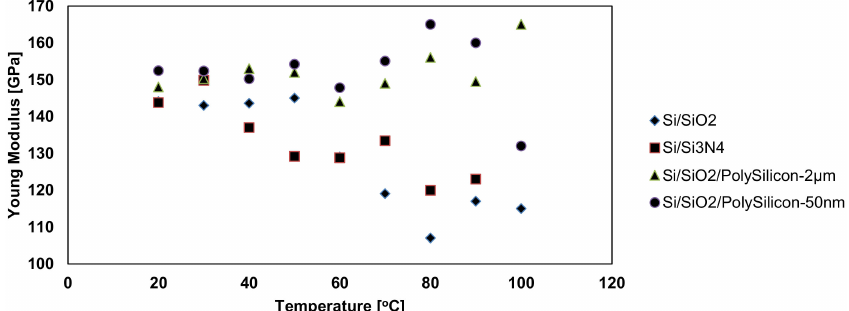
Figure 20. The Young modulus with respect to temperature for Si/SiO 2 , Si/Si 3 N 4 , Si/SiO 2 /PolySi—2 µ m and Si/SiO 2 /PolySi—50 nm.